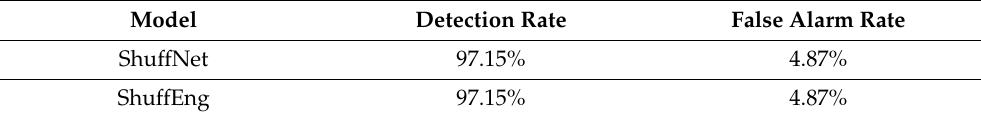
Table 4. Detection and false alarm rates in different inference modes in multiple scenarios (unit: %). Model